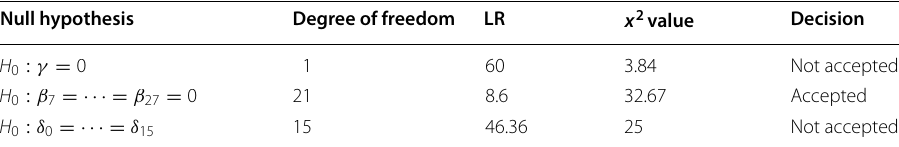
Table 7 Summary of the test of hypothesis. Source: Computed from Field Survey Data,